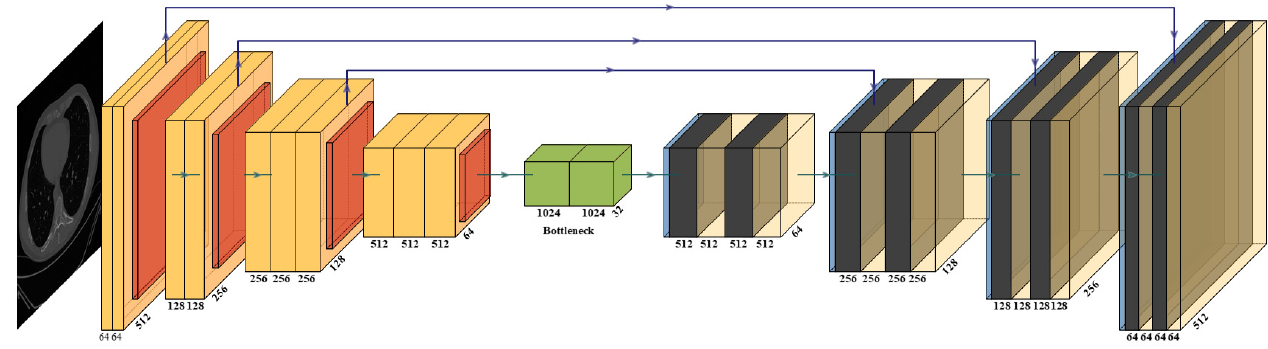
Figure 8. VGG ‐ UNet’s architecture. Figure 8. VGG-UNet’s